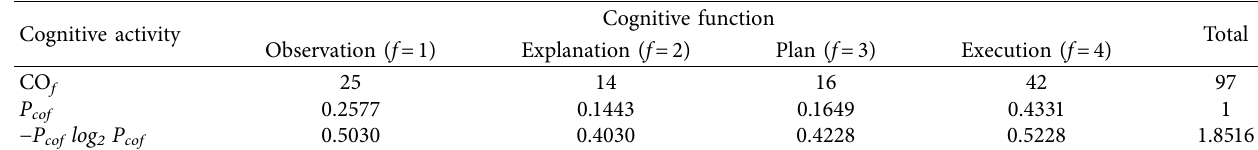
Table 11: Cognitive complexity of setting in